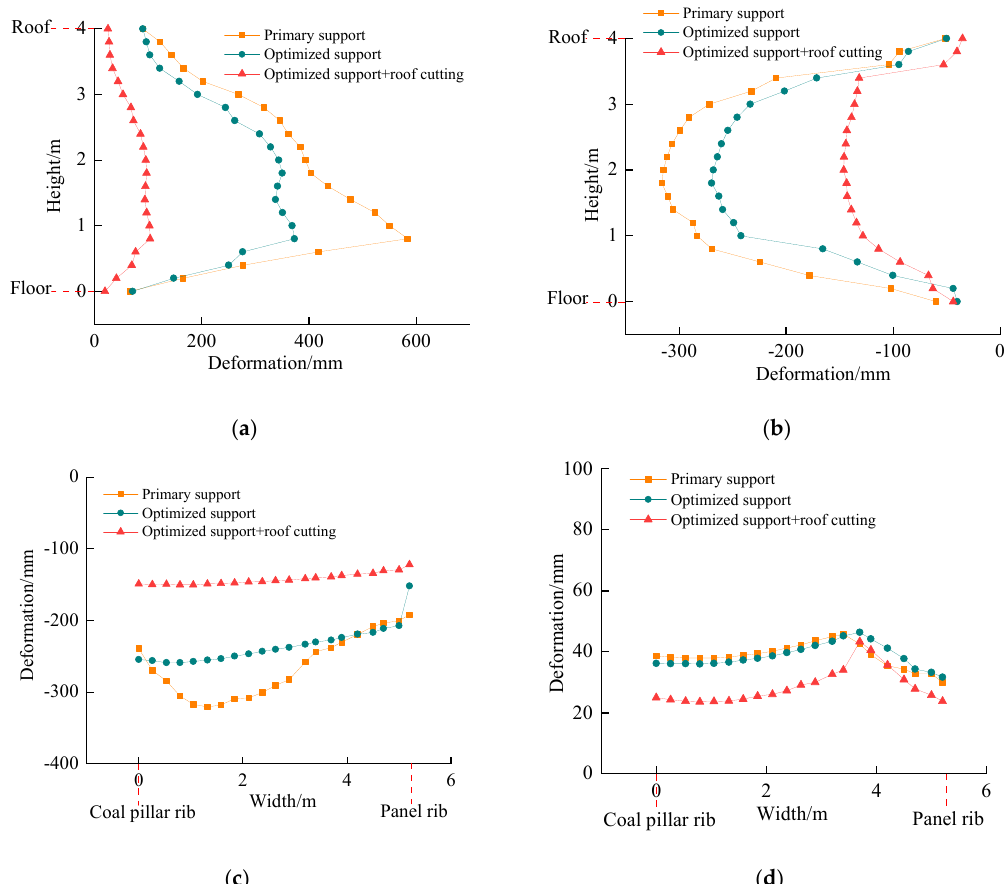
Figure 17. Deformation of the surrounding rock of the roadway. ( a ) Coal-pillar rib; ( b ) panel rib; ( c ) roof sagging; ( d ) floor bulging.